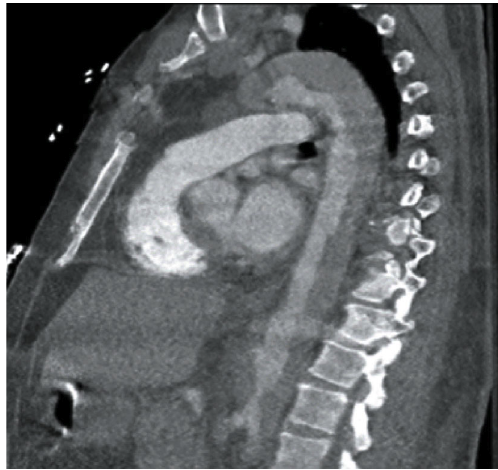
Figure 3: Extensive aortic